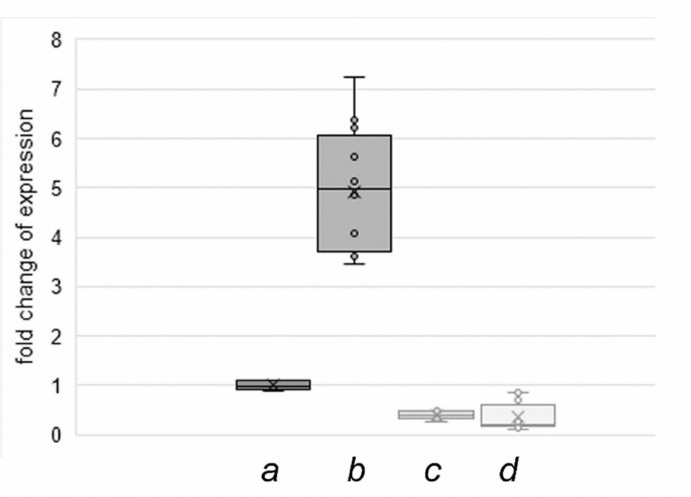
Figure 7. Atat1 expression in standard medium and serum starvation medium in NIH3T3 “DSMZ” and NIH3T3 F-con cells. Serum deprivation induced Atat1 expression in NIH3T3 “DSMZ” cells (b) compared to cultivation in standard medium (a). In NIH3T3 F-con cells Atat1 expression is repressed in standard medium (c) and is also not induced by serum deprivation (d). Three to four biological replicates. Triplicate measurements. Student’s t -test all p *** related to NIH3T3 “DSMZ” cultivated in standard medium. The median is represented by a line, the average by a cross and individual values by